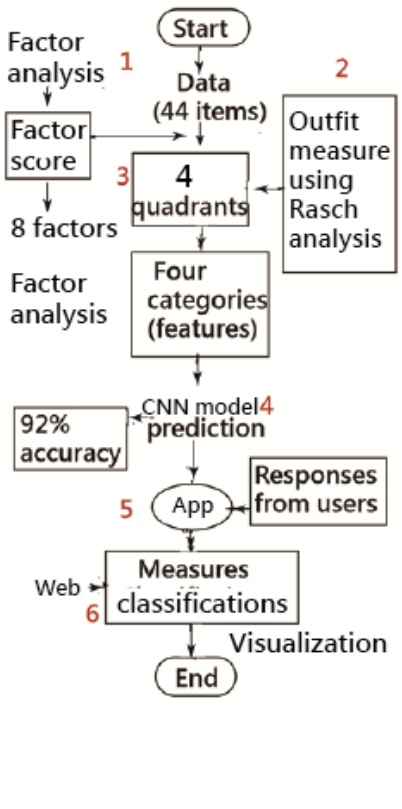
Figure 2. The study flowchart. CNN: convolutional neural